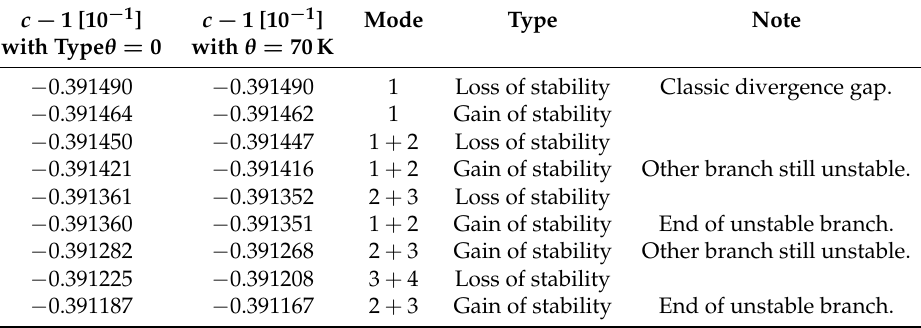
Table 3. Critical points, where the real part of at least one solution enters or exits the positive half-plane. Air mass moves with the panel, v ∞ = V 0 . Note the scale of c